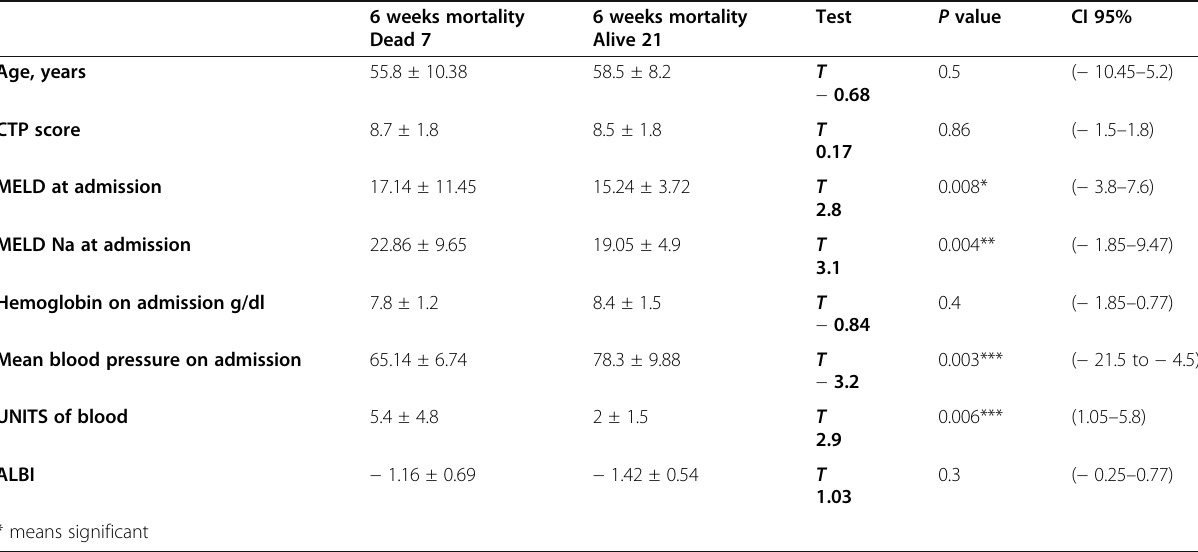
Table 3 Univariate analysis for mortality 6 weeks follow-up